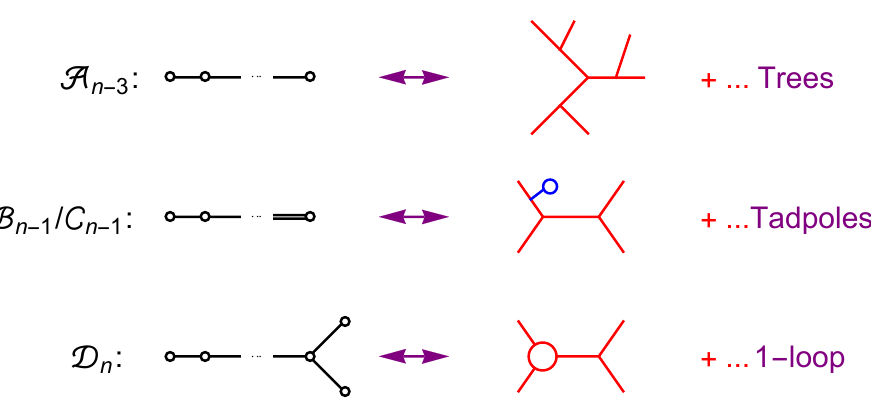
Figure 1 . The correspondence between cluster algebras, Dynkin quivers and scattering amplitudes. B / C , which turn out to be the same and are known as “cyclochedra”, compute n − 1 n − 1 the subset of 1-loop amplitudes involving the emission of tadpoles. This polytope is also directly realized as one of the facets of the D n